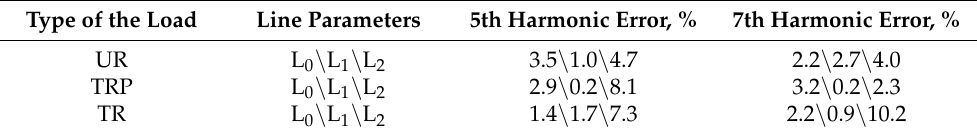
Table 4. The error of determination the current harmonic magnitudes via passive filter. Type of the